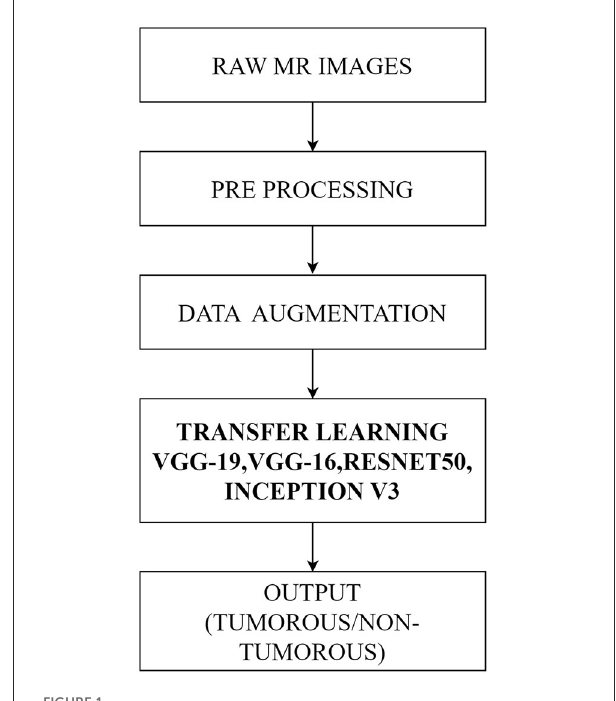
FIGURE1 Flowchart of the proposed methodology using pre-trained DCCN